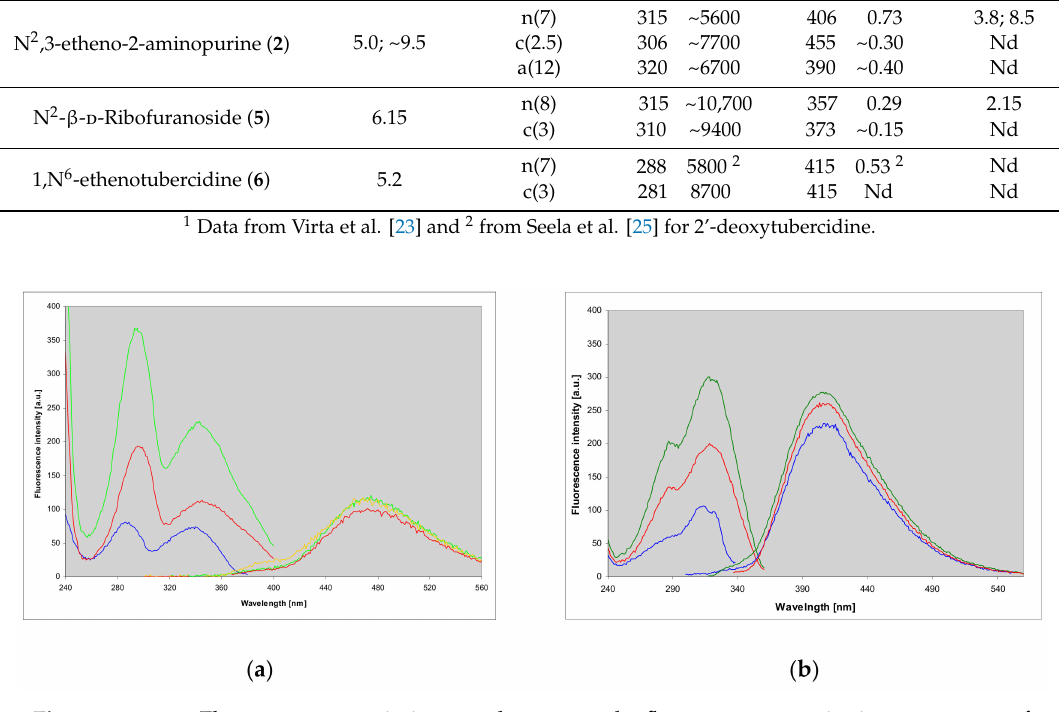
Figure 3. Fluorescence emission and corrected fluorescence excitation spectra of: ( a ) 1,N 2 -etheno-2-aminopurine ( 1 ), and ( b ) N 2 ,3-etheno-2-aminopurine ( 2 ) in neutral aqueous solution. Emission spectra were measured with excitations at 310, 330 and 360 nm (green, yellow and red; left panel), and 310, 330 and 350 nm (green, blue and red, right panel), and excitation spectra with observations at 400, 440 and 480 nm (blue, green and red, left panel) and at 380, 400 and 440 nm (blue, green and red, right